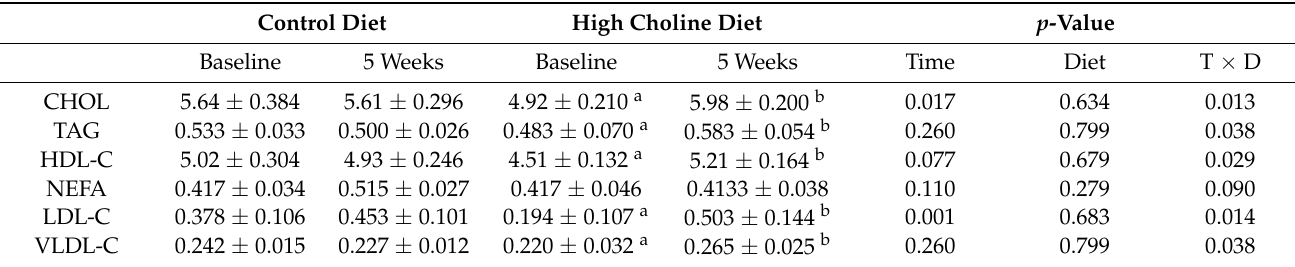
Table 3. Serum lipid profiles (mmol/L) in 12 chronically obese cats at baseline and after feeding a control food (458.7